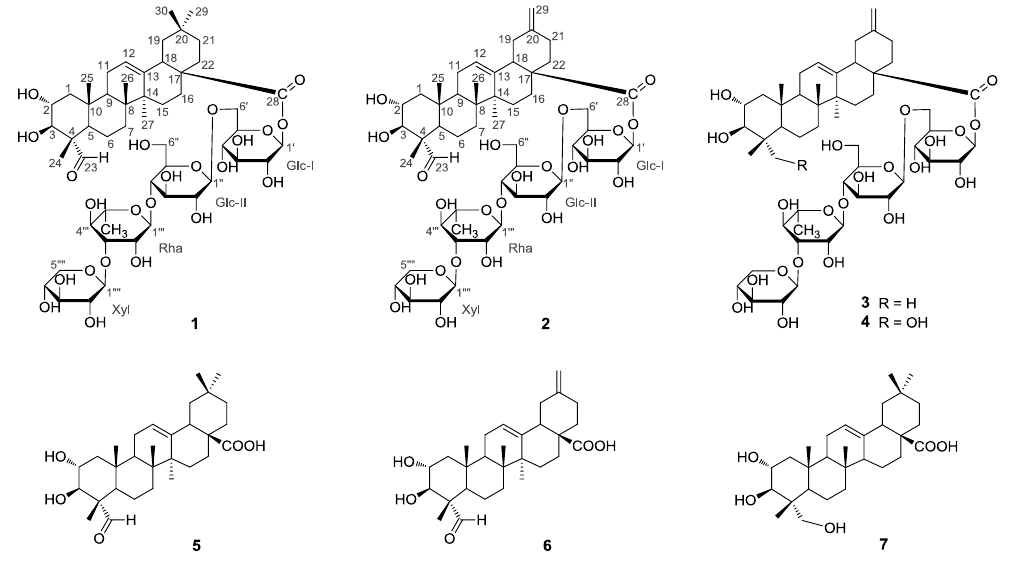
Figure 1. Chemical structures of compounds 1 – 7 .